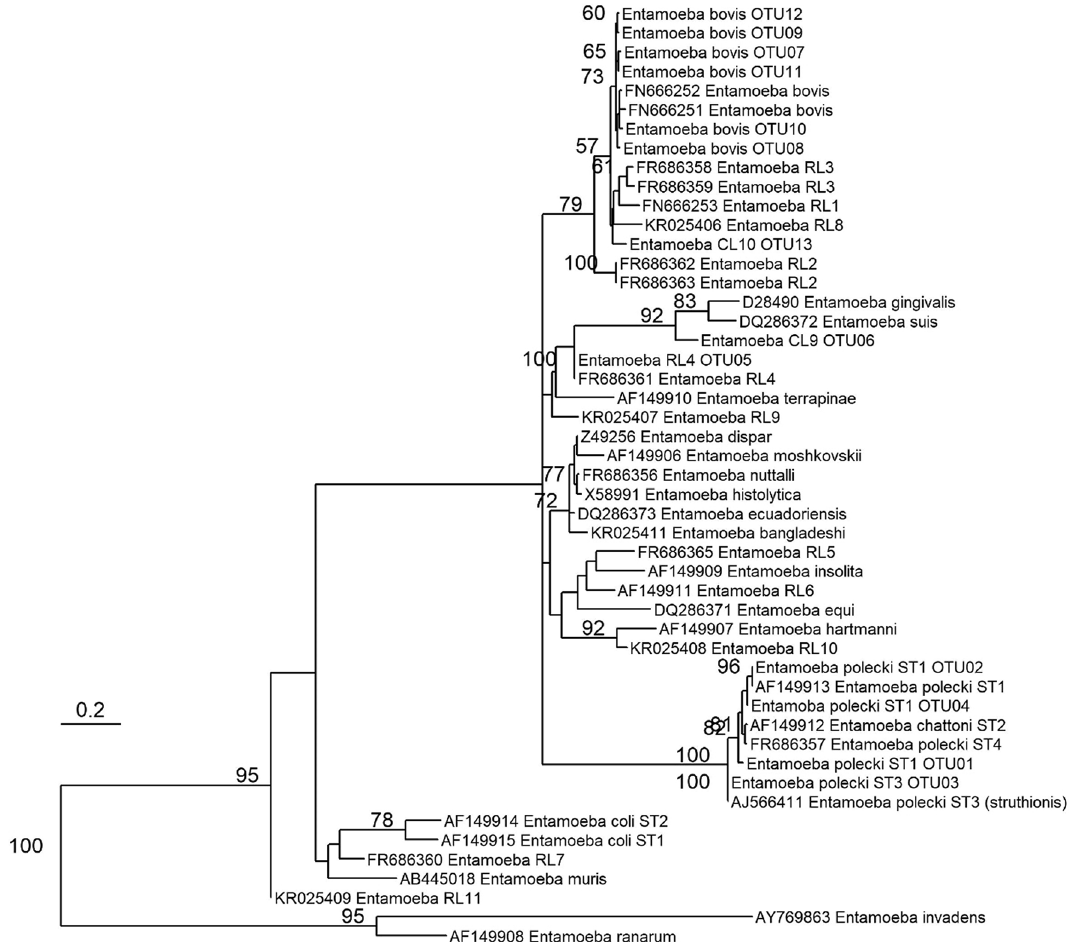
Figure 2. Phylogenetic relationships of Entamoeba species based on 292 total positions in the 18S rDNA gene. Tree was inferred using an unrooted maximum likelihood method. The evolutionary distances were computed using the General Time-Reversible Model modeled using a gamma distribution (shape parameter = 0.5). Bootstrap proportions > 50% (over 1000 replicates) are shown next to the branch nodes. Accession numbers for the reference sequences are listed behind the Entamoeba species name. The scale bar represents 0.2 substitution per